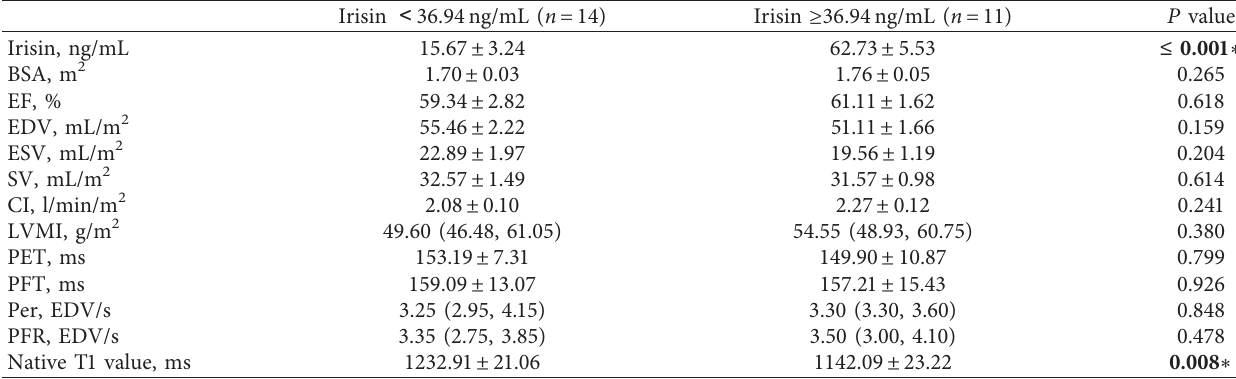
Table 3: Cardiovascular magnetic resonance parameters of two subgroups in patients with severe hypothyroidism according to the cutoff value of serum irisin levels.